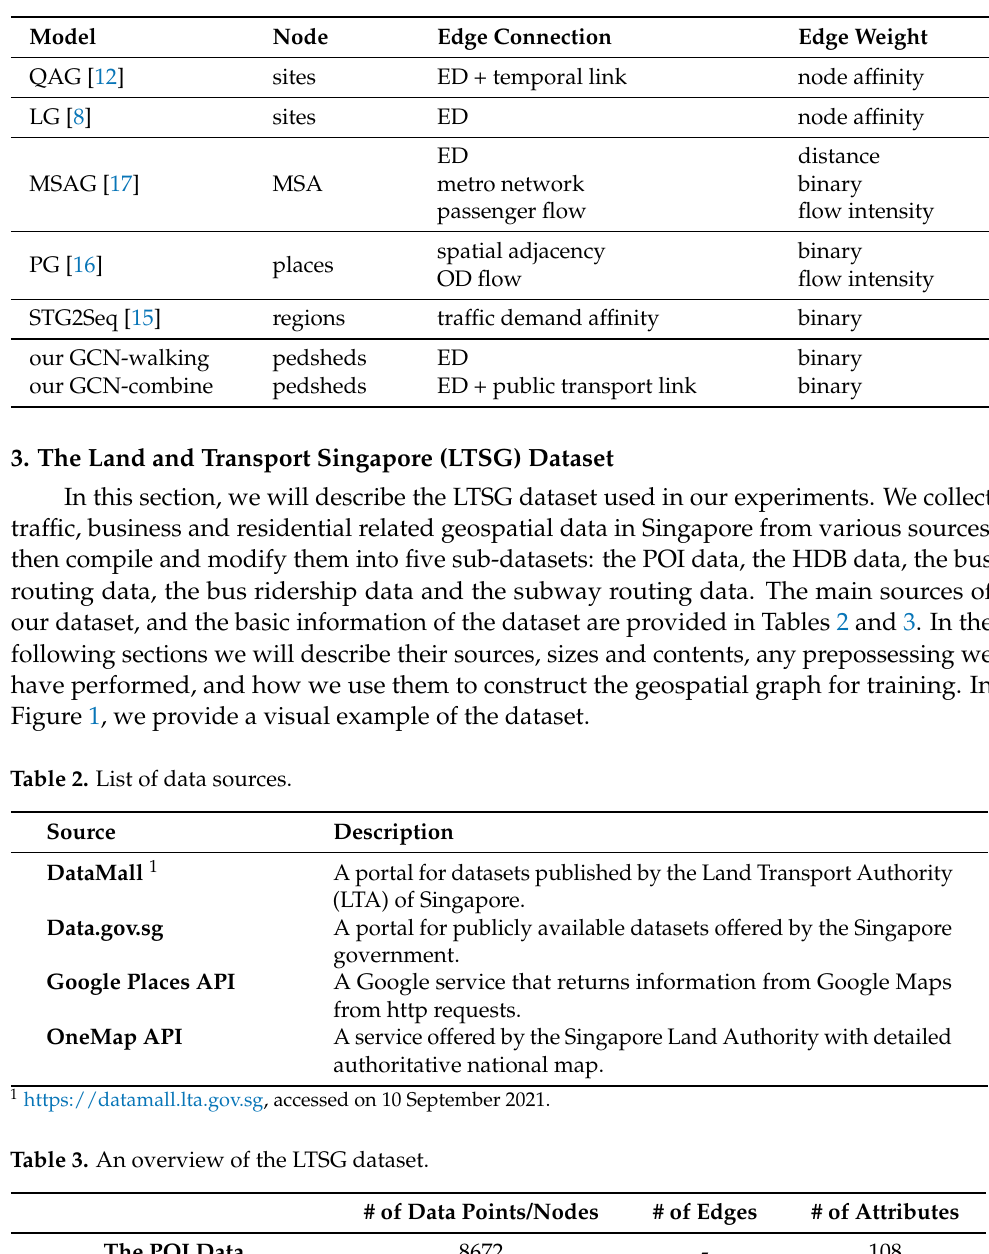
Table 1. Comparison of the graph construction of the graph-based geospatial analysis methods. ED represents Euclidean distance. OD represents Origin–Destination. MSA represents Metro Sta- tion Area.